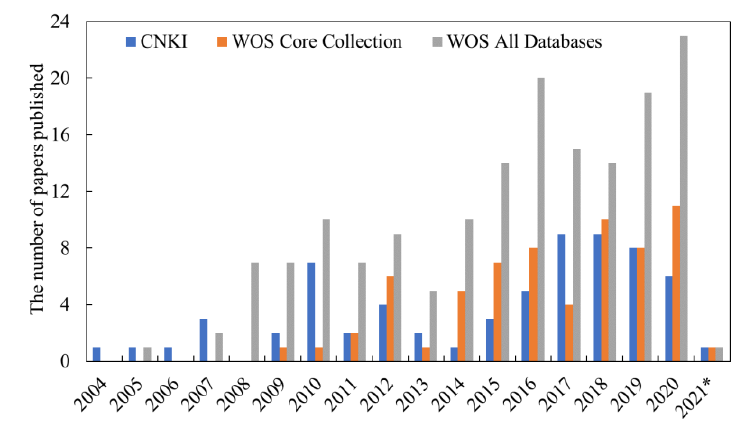
Figure 1. Publication statistics.